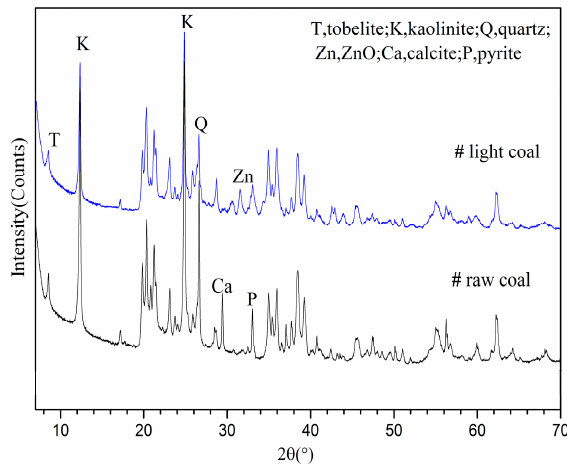
Figure 1. XRD patterns of LTA of WX raw and preheated WX light coal.